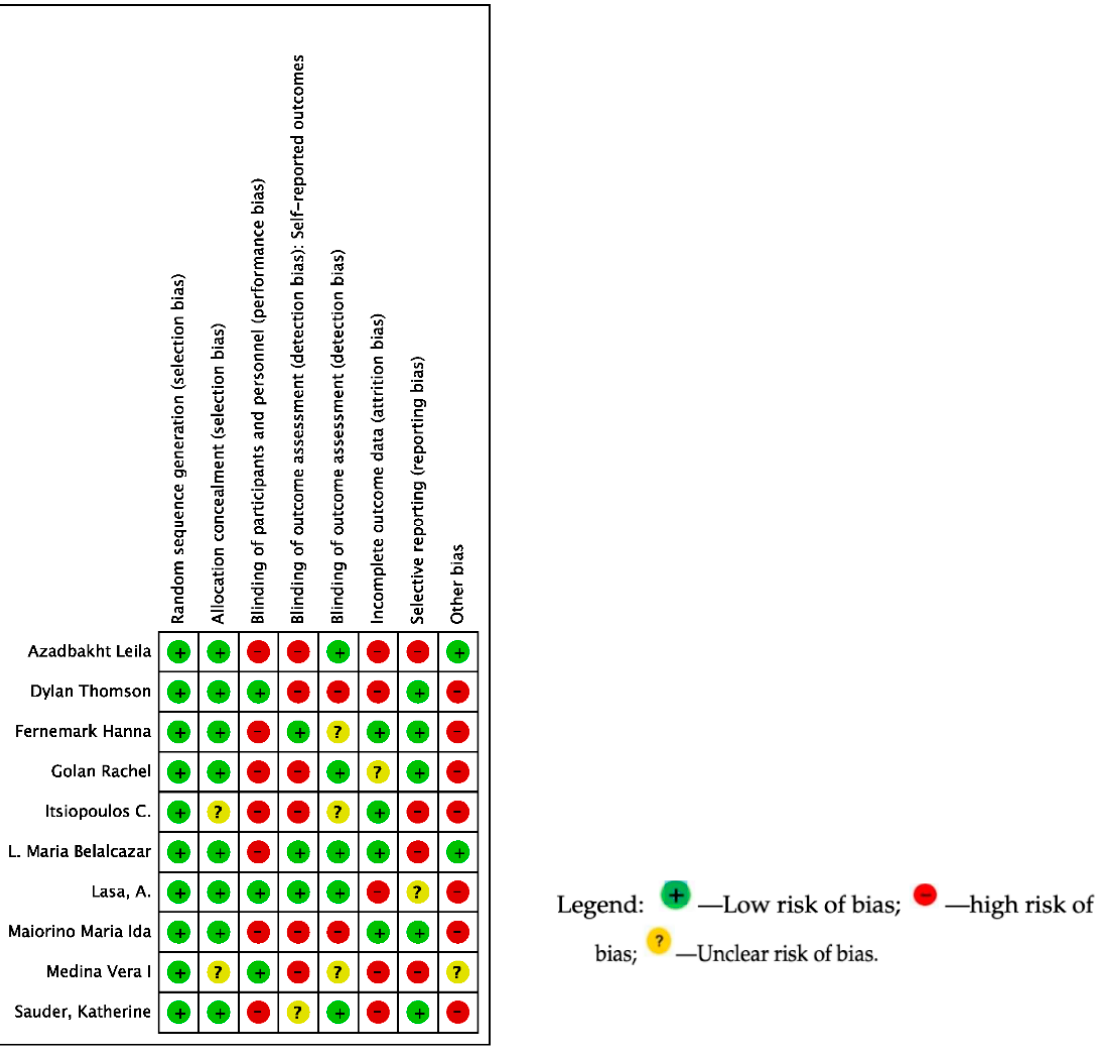
Figure 2. Risk of Bias of the Included Studies (n = 10).